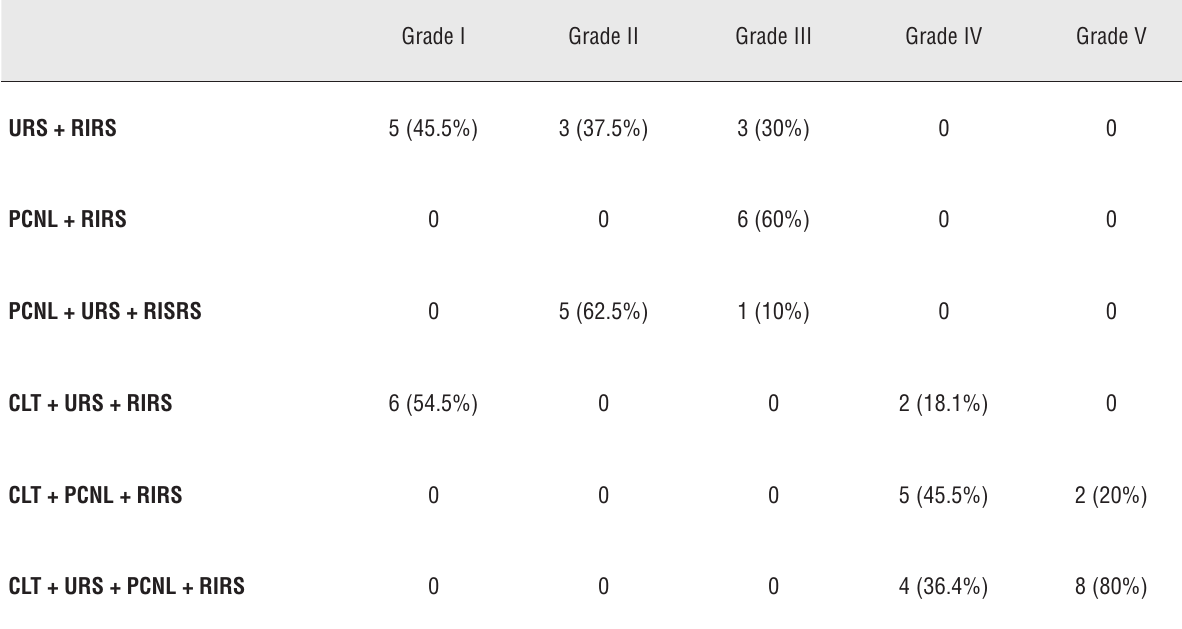
Table3. Procedures according to FECal